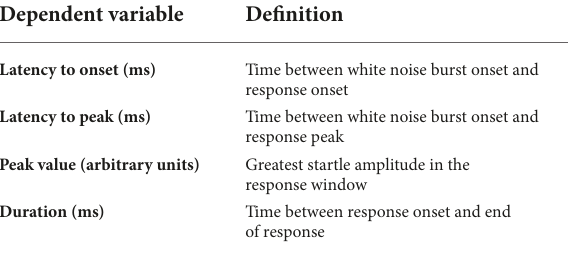
TABLE 1 Descriptions of outcome measures from the acoustic startle test.